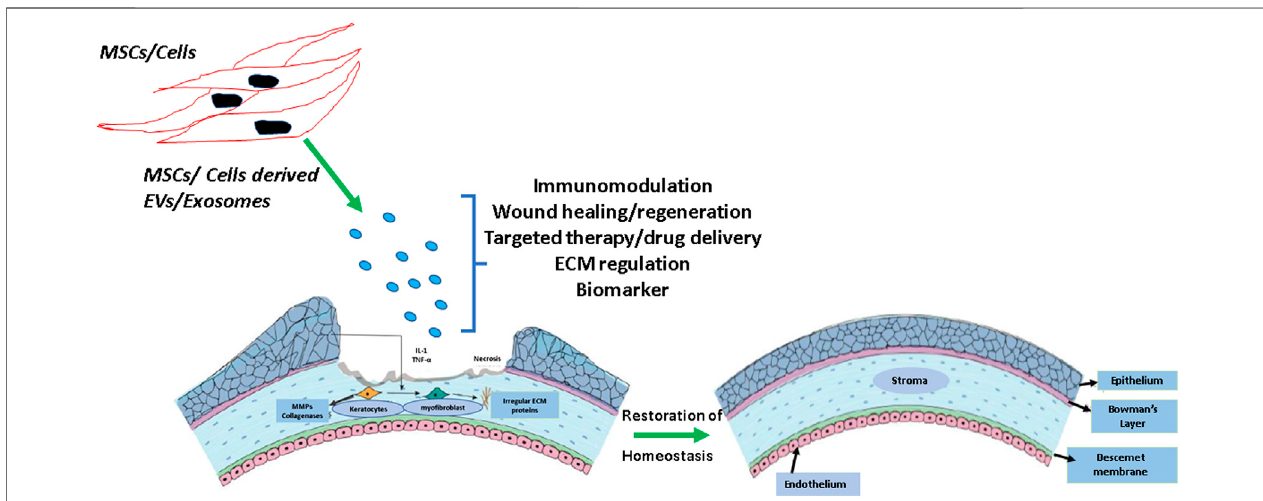
FIGURE 2 | Schematic showing the effect of mesenchymal stem cells (MSCs) and other cell type-derived exosomes on corneal wound healing and fi brosis. Exosomesareactivelyinvolvedinimmunomodulationandextracellularmatrix(ECM)remodeling.Theuseofexosometherapycouldbeapromisingapproachtomaintain corneal homeostasis and maintaining